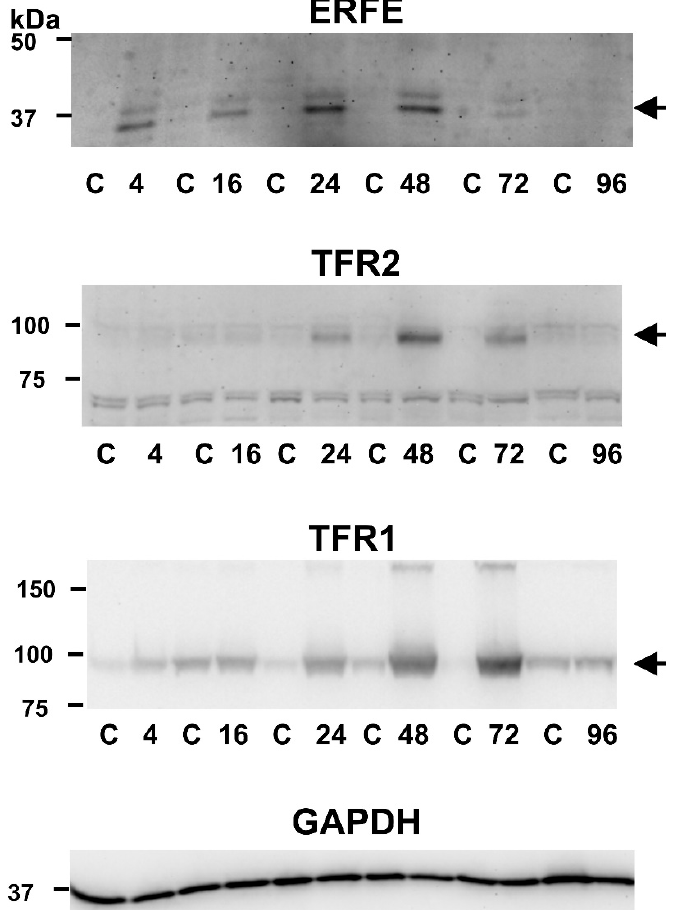
Figure 3. Single injection of EPO upregulates ERFE, TFR2 and TFR1 protein in the spleen. EPO was administered at 200 U/mouse; target proteins were determined at the indicated time points (4, 16, 24, 48, 72 and 96 h after EPO administration) in spleen membranes isolated from pairs of control (C) and EPO-treated animals. Sample loading is 35 µg protein/well, GAPDH is used as loading control. Arrows denote the target protein bands.